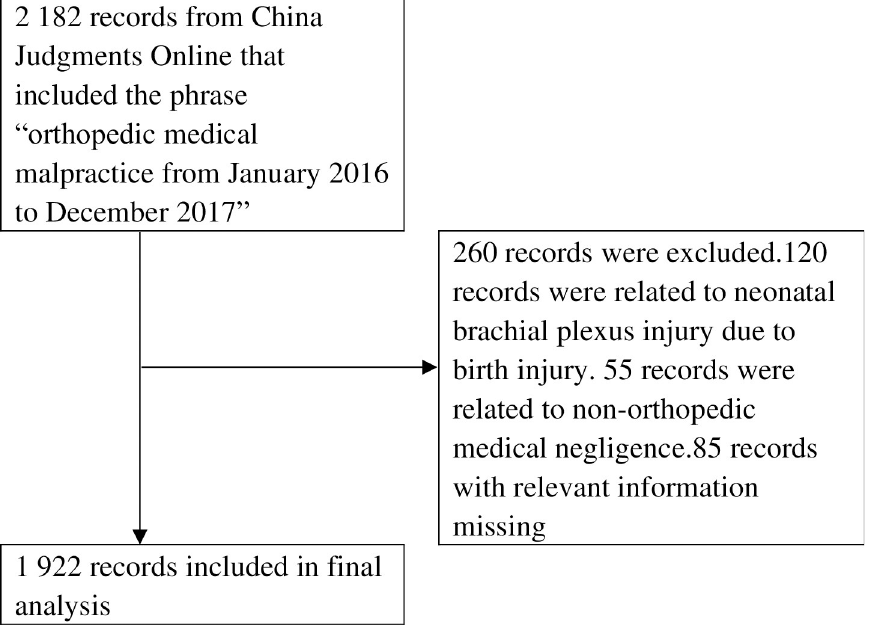
Fig 1. Flowchart of the selection of records of medical litigation in China between 2016 and 2017.